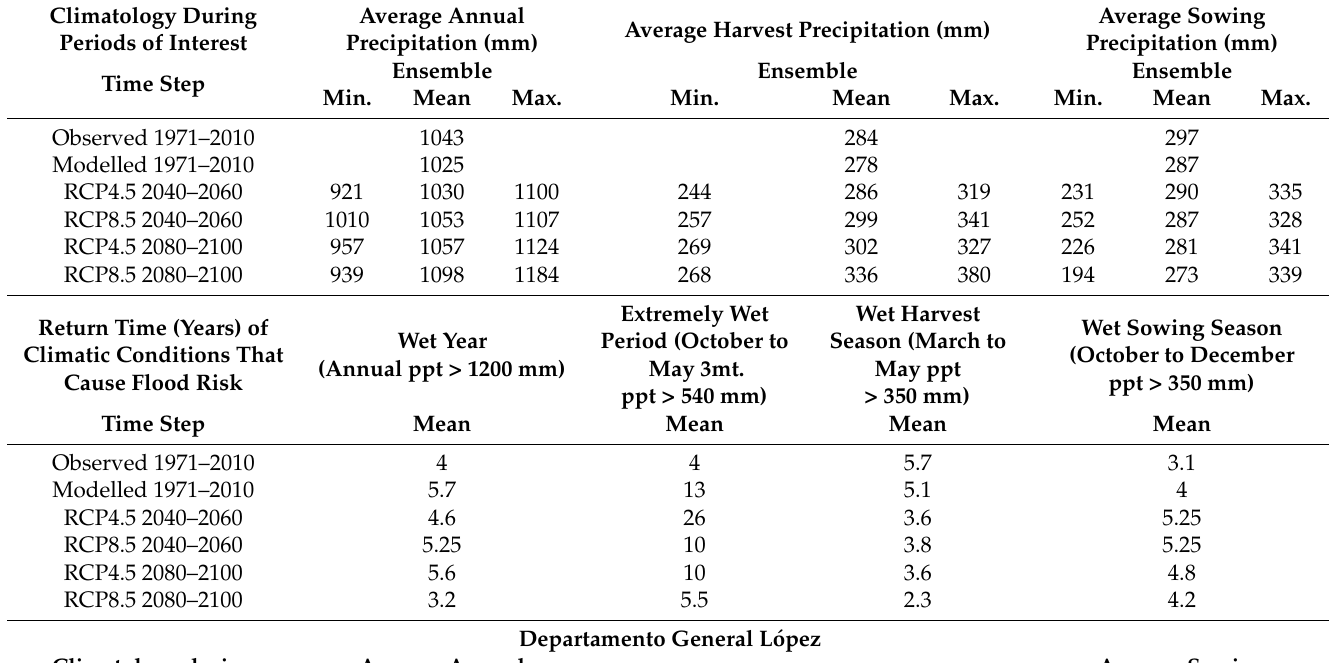
Table 3. Annual and seasonal precipitation change in the PGJdM (A) and the DGL (C) and return period for flood risk climatic conditions in the PGJdM (B) and the DGL (D) for 2040–2060 and 2080–2100 based on the RCP4.5 and RCP8.5 scenarios. The tables indicate the average ensemble change and the ensemble extremes. In addition, historical modelled precipitation is compared to historical observed precipitation in both locations. For the PGJdM, the modelled historical precipitation contains a correlation of R2 of 0.94 with observed data using the Pearson correlation coefficient (Figure A2). A similar analysis for the DGL demonstrated an R2 of 0.97 (Figure